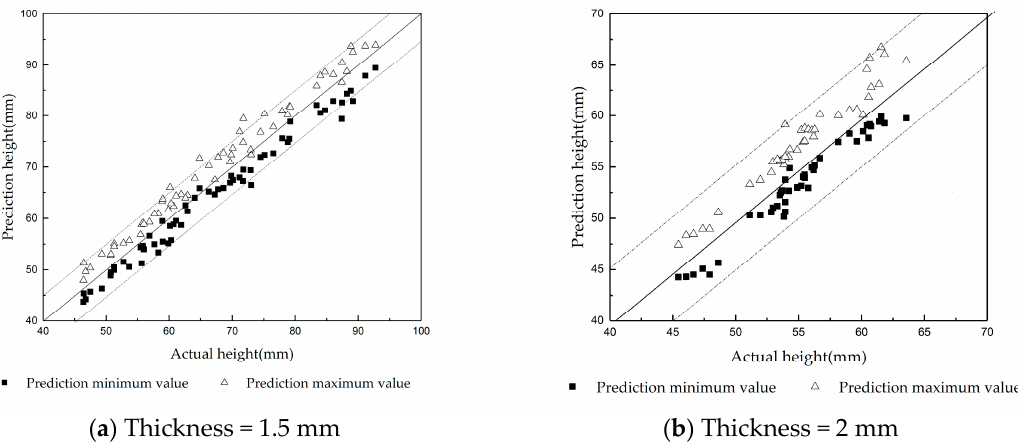
Figure 11. The performance of the floating height prediction in the transition state. The abscissa of the solid block represents the actual value of the strip floating height and the ordinate is the corresponding predicted minimum value of the soft-transition model. The hollow triangle appears in pairs with the solid block. The abscissa represents the actual value of the same strip floating height and the ordinate is the corresponding predicted maximum value of the soft-transition model.